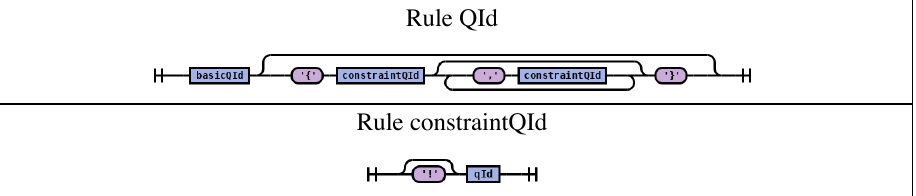
Figure 2. Grammar of a MQL Qualified Identifier (QId) for representing a table or a field. A “constraintQId” permits characterizing the path for resolving the table or the field. “!” is used to exclude a table or a field from the path.